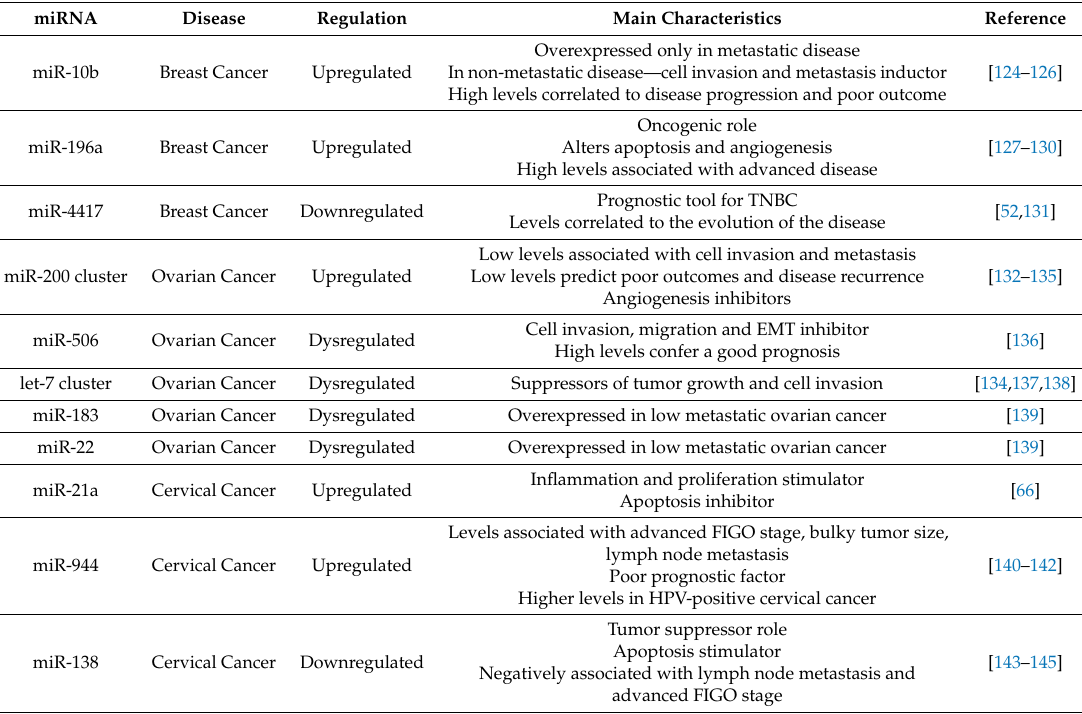
Table 1. MicroRNA (miRNA) regulation in